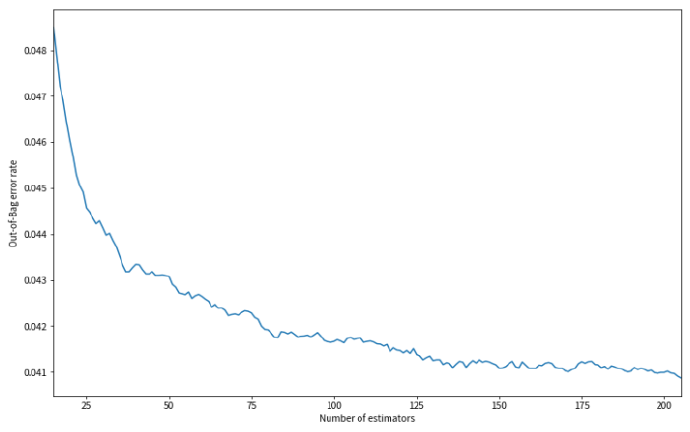
Figure 6. Binary classification error with a given number of trees.